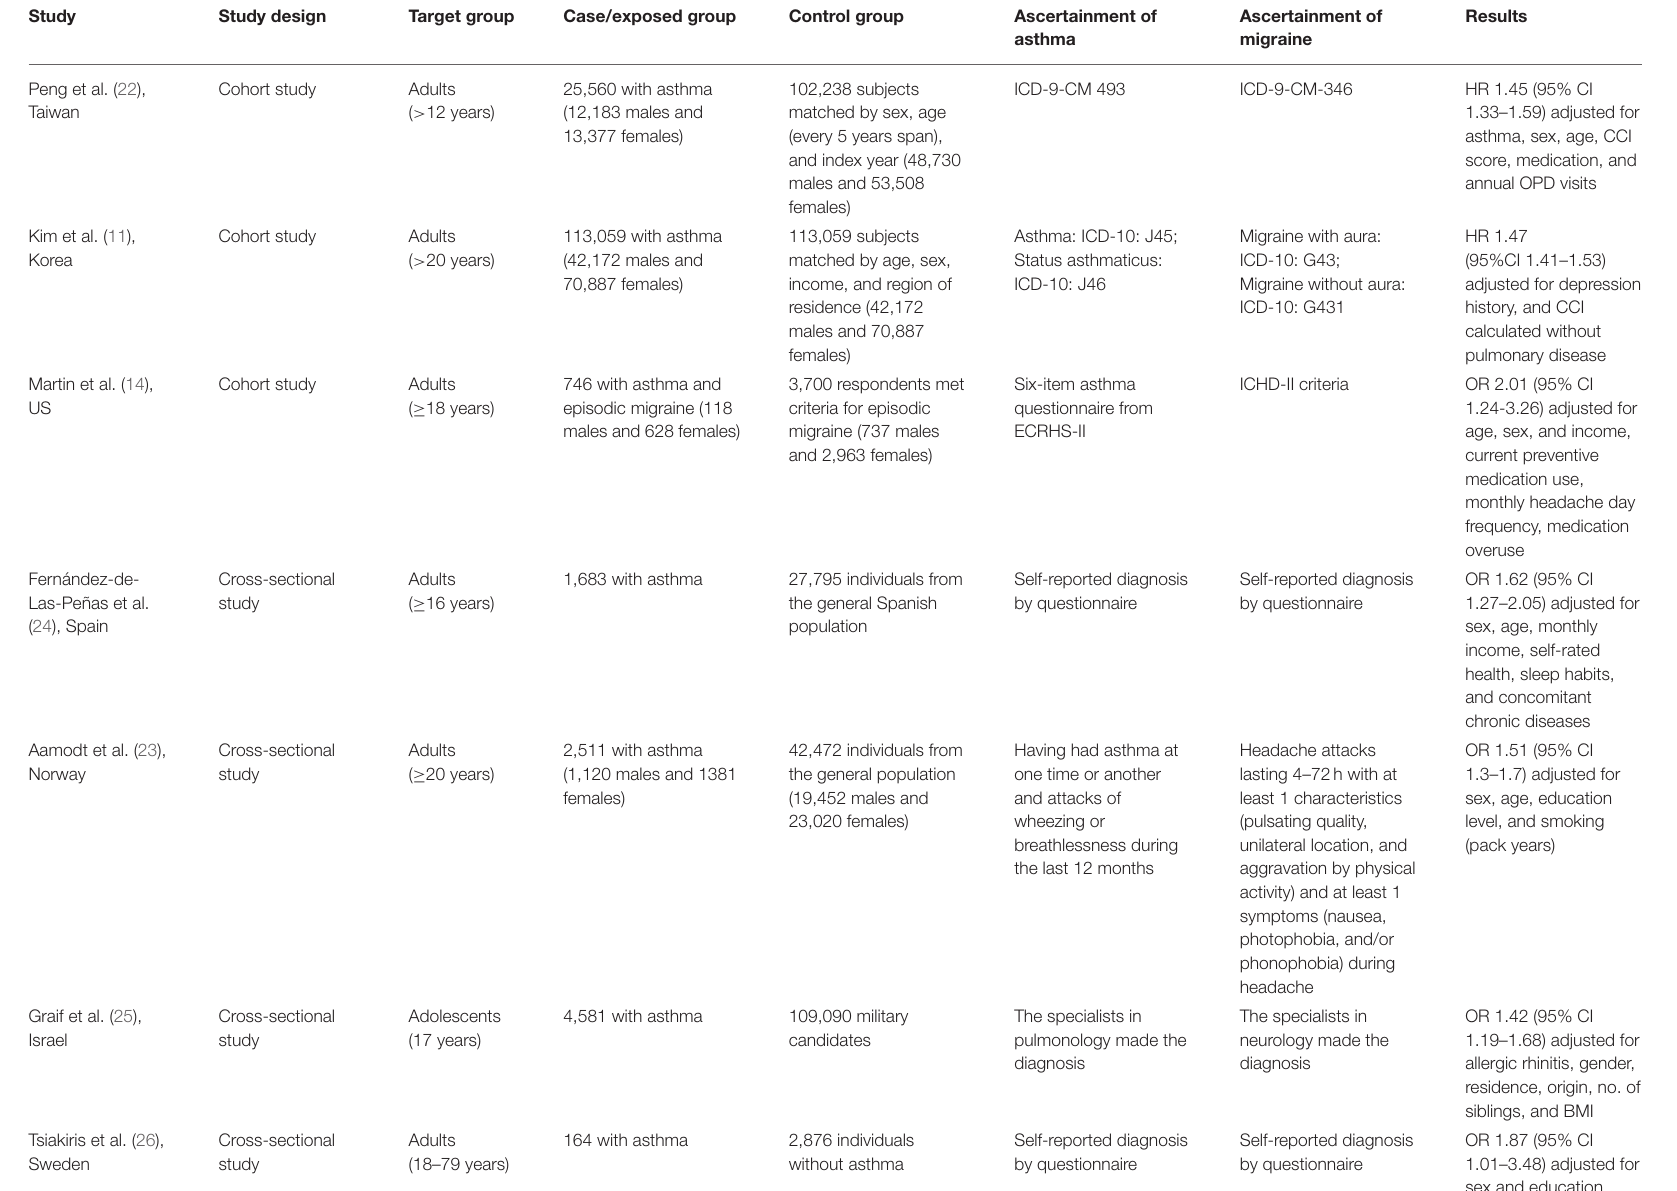
TABLE 2 | Characteristics of included